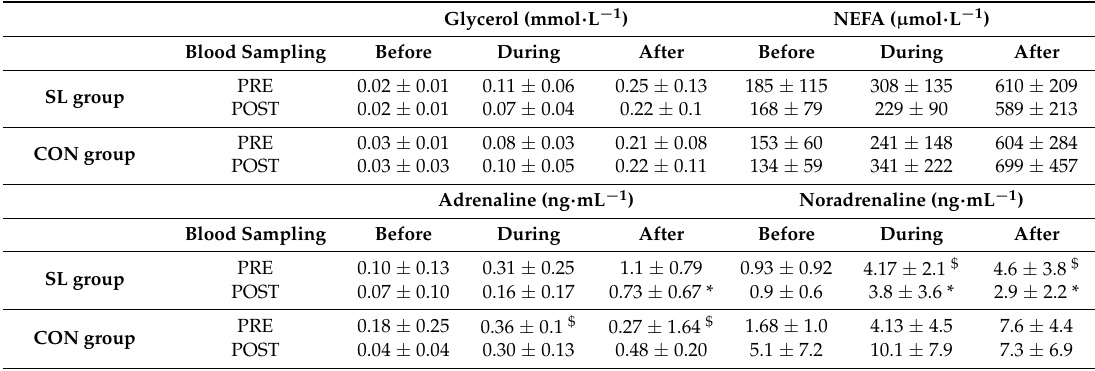
Table 3. Blood analysis sampled before, during (at 1 h) and immediately after (at 2 h) the submaximal test for markers of lipid metabolism (glycerol, non-esterified fatty acid (NEFA)) and catecholamine